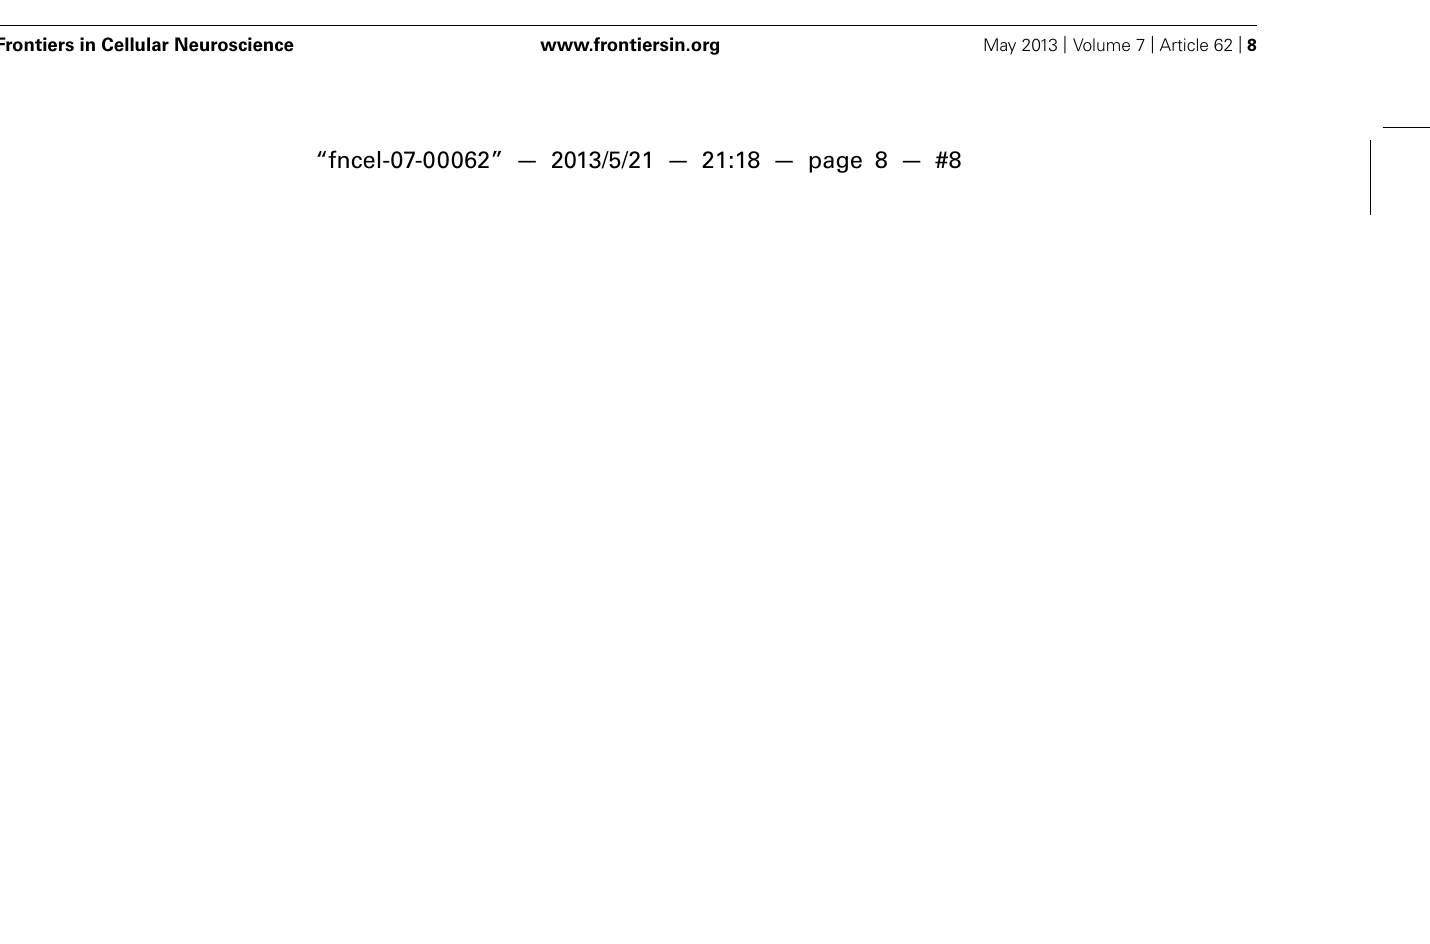
hippocampal CA1 and (B) V1 visual cortex.Time course of fEPSP slopes pre- and post-TBS and representative traces (left, control; right, CNF1; horizontal scale bar: 1.5 ms; vertical scale bar: 1.5 mV) in (C) hippocampal CA1 (control, n = 12; CNF1, n = 13) and (D) V1 visual cortex (control, n = 12; CNF1, n = 10). Paired-pulse facilitation at different interstimulus intervals (control: n = 6, CNF1: n = 6) in (E) hippocampal CA1 and (F) V1 visual cortex. All recordings were performed 10–18 days post i.c.v. injections. Data are mean ±